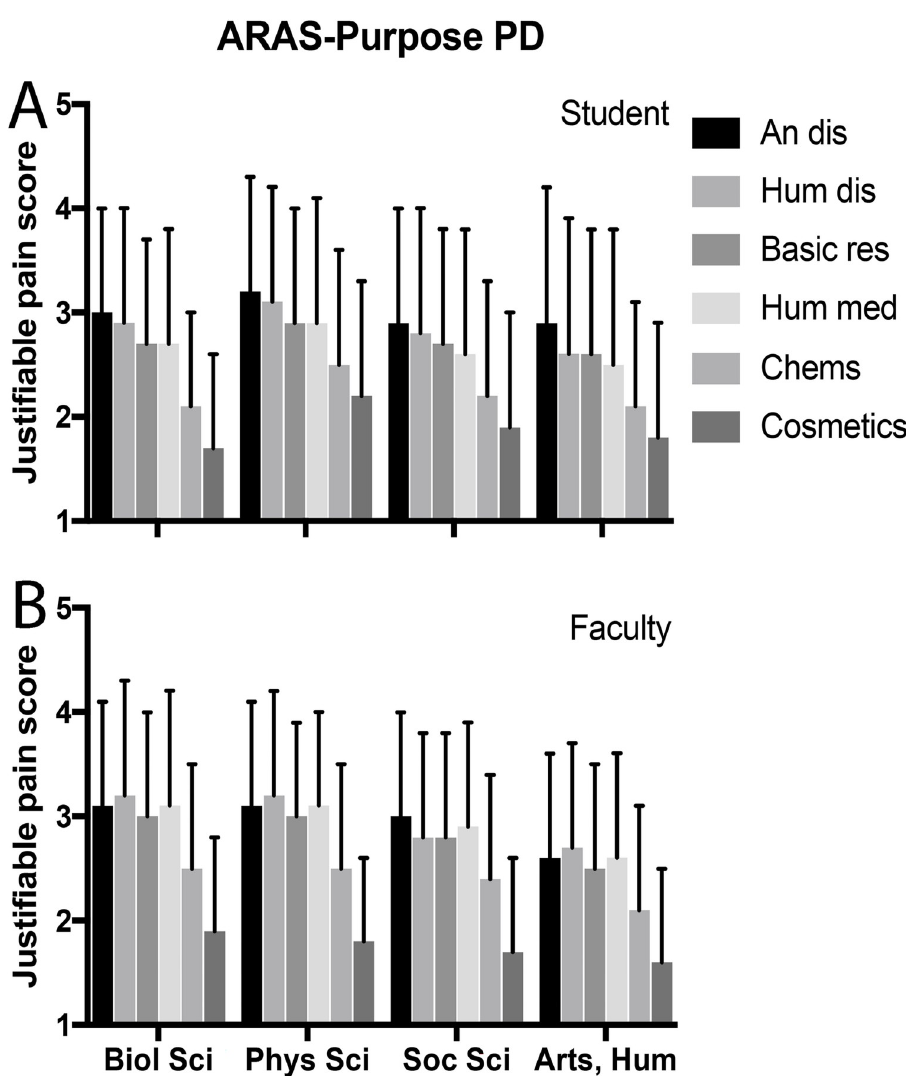
Fig 1. ARAS-purpose PD score versus